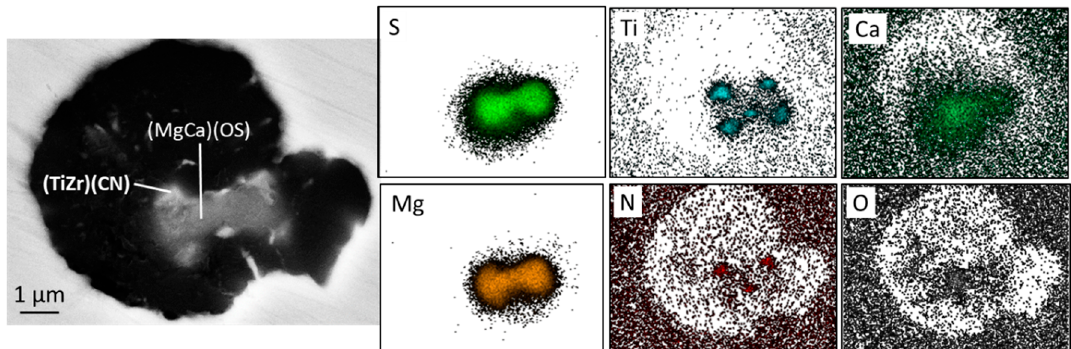
Figure 22. Effect of titanium content in the base melt: ( a ) On the composition of the inclusions found in graphite spheroids (all melts); ( b ) on the nodule count (not inoculated melts) [106].